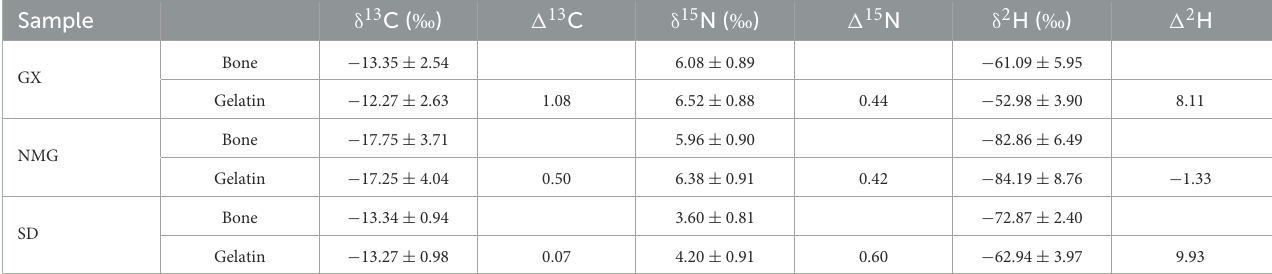
TABLE 3 A comparison of the mean δ 13 C, δ 15 N, and δ 2 H values and standard deviations in gelatin samples and bone raw materials from different regions.